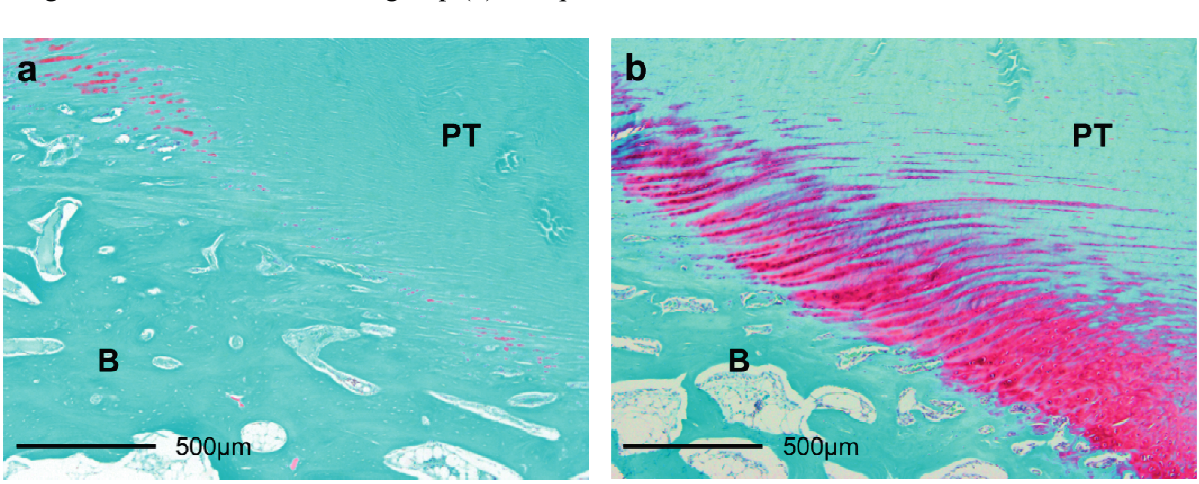
Figure 5. Safranin-O staining of histological sections of PT insertions 4 weeks after surgery (×40). The thickness of the stained GAGs area (stained red) in the elongation group ( b ) was greater than that in the sham group ( a ). PT: patella tendon. B: bone.